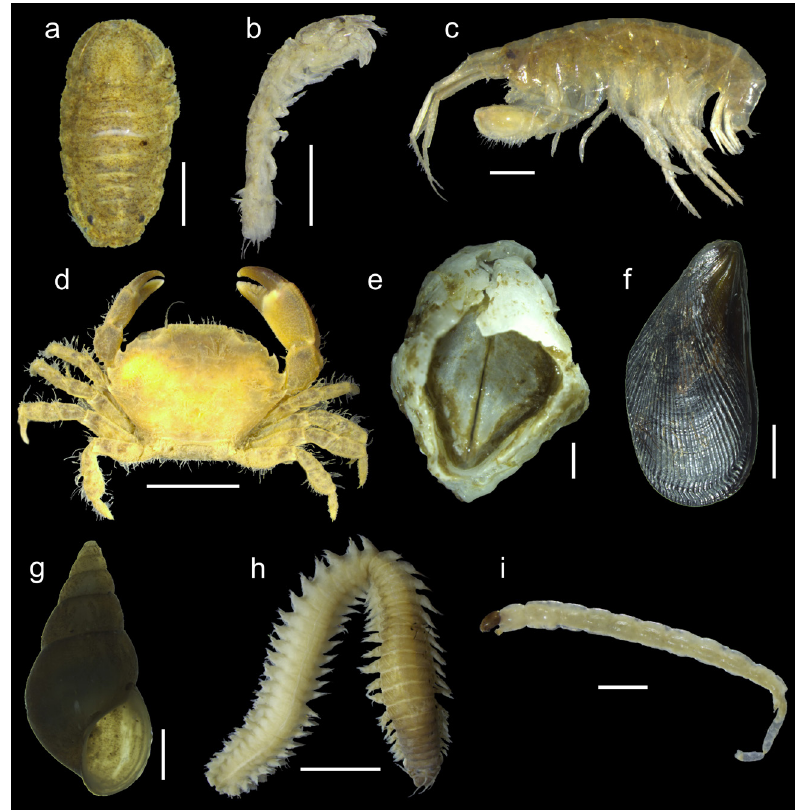
Figure 2. Macrofauna